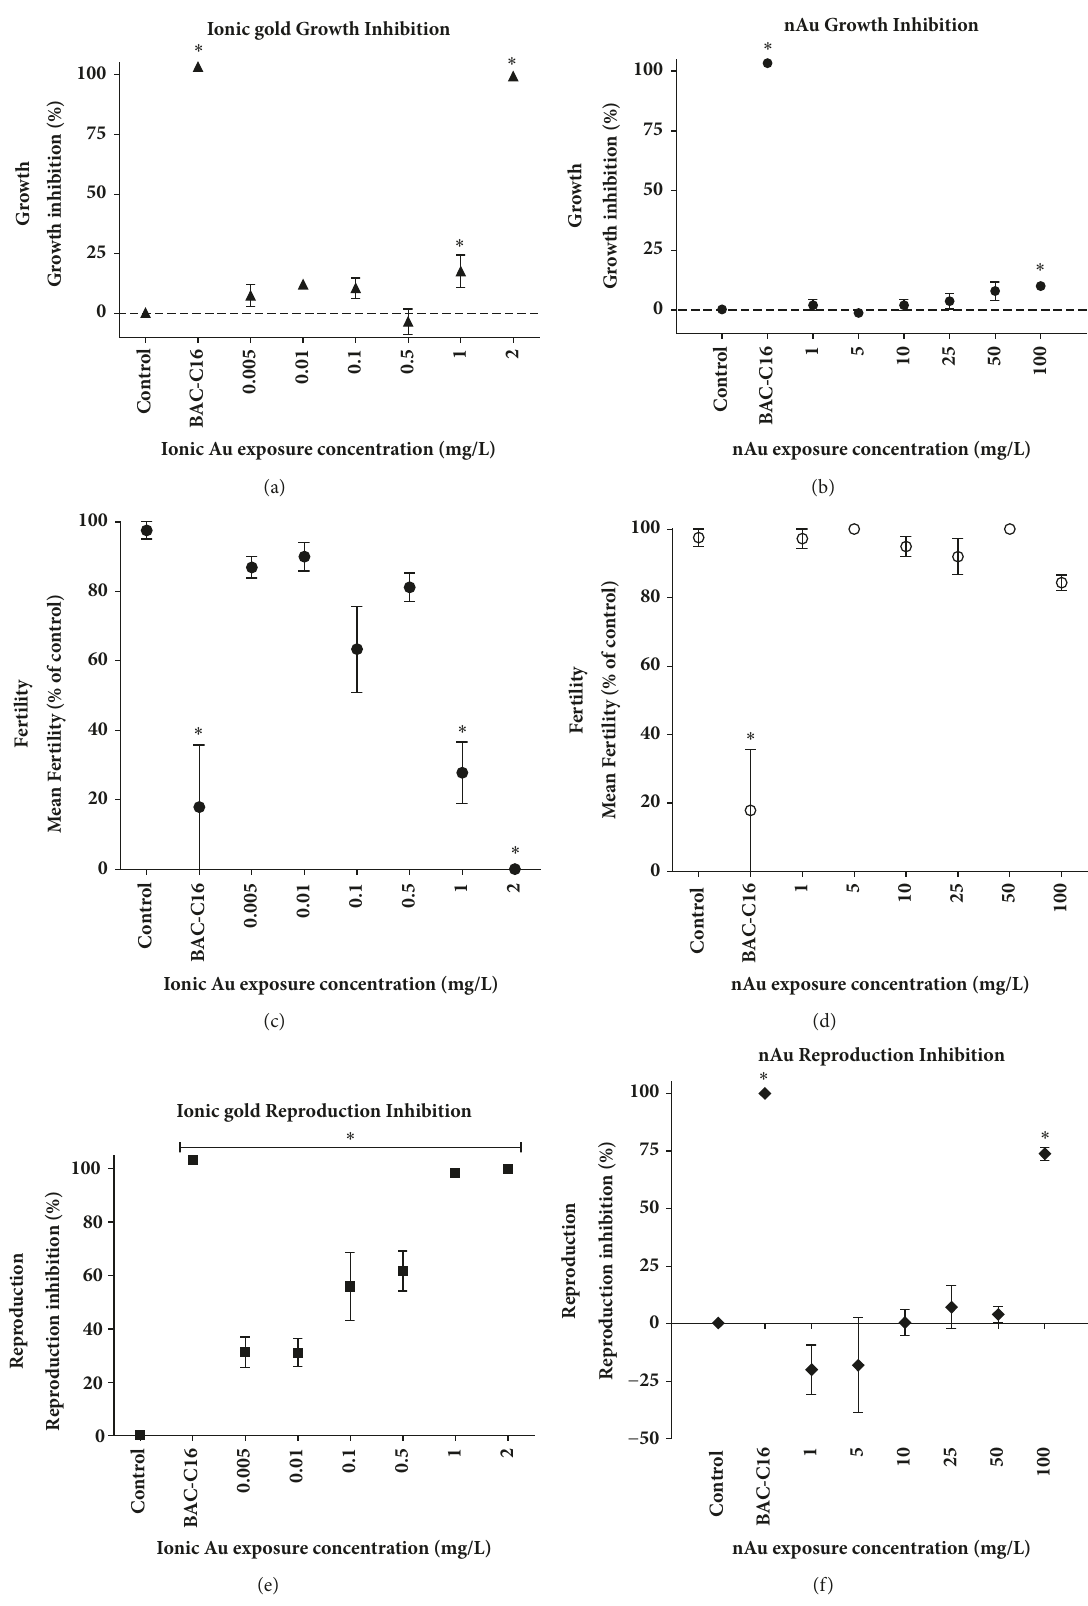
Figure 4: Growth inhibition (% inhibition), fertility (% of control), and reproduction (% inhibition) of nematodes exposed to ionic and nanogold. The asterisks indicate statistical difference (p < 0.05 ) from the